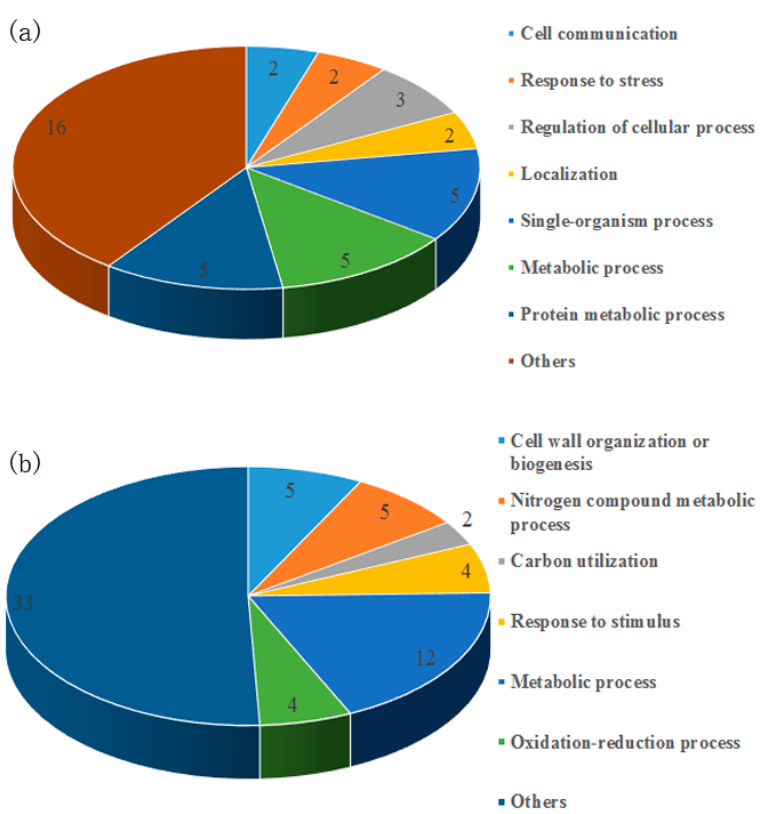
Figure 1. Classification of identified secreted proteins into functional categories using Blast2Go. ( a ) Proteins exclusively secreted in the +BP sample; ( b ) Proteins with higher accumulation in the +BP sample.